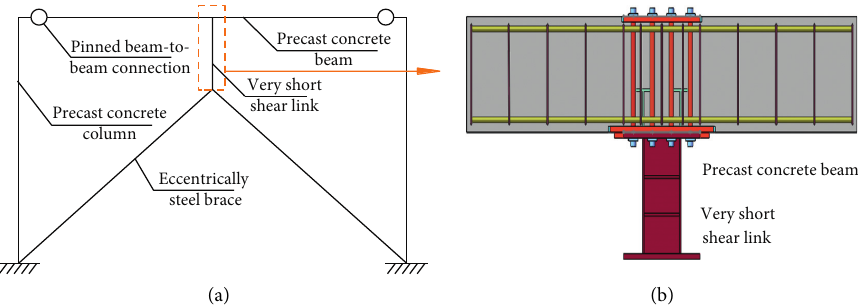
Figure 1: Prefabricated reinforced concrete-Y shaped eccentrically steel brace structure: (a) PRC-Y-ESBS; (b) PCB-SLCC.